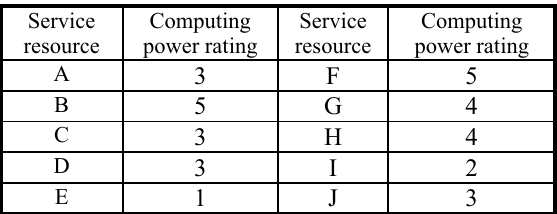
Table 1. A example of computing power rating